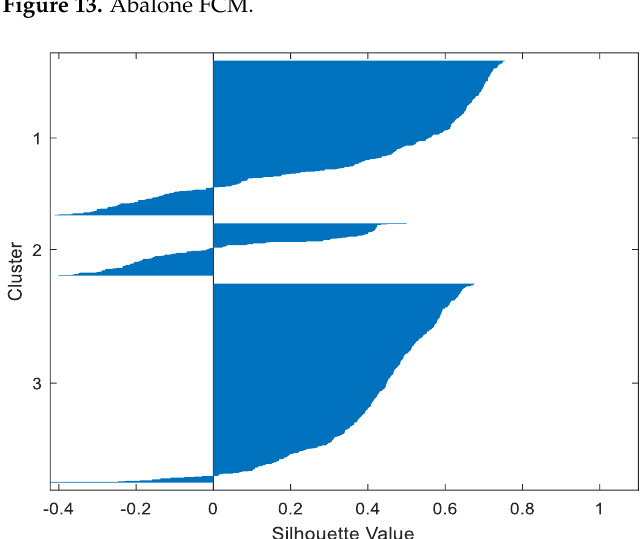
Figure 15. Pima FP-Conv-CM.